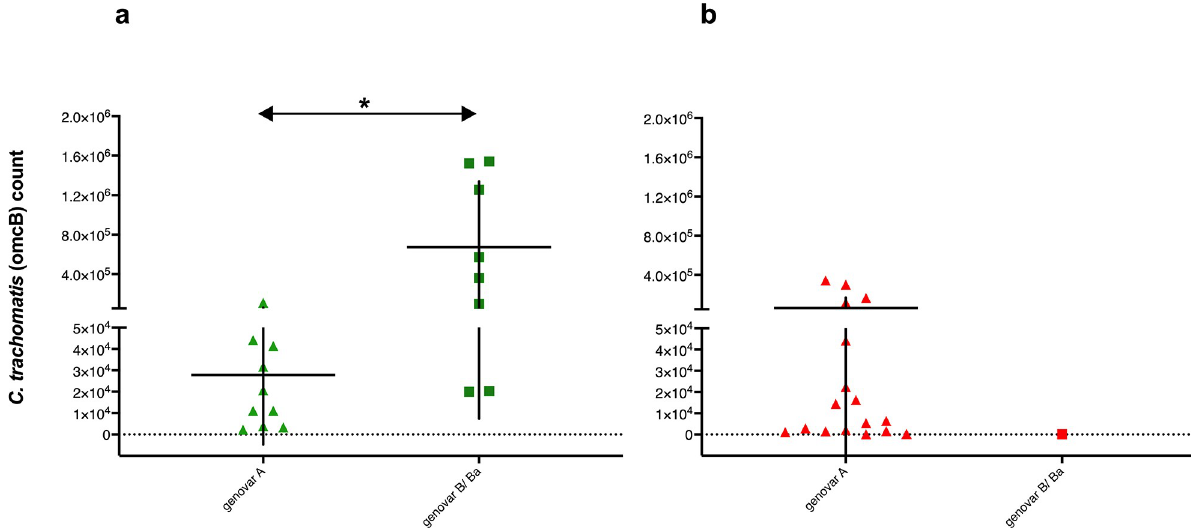
Fig 3. Bacterial loads for different Ct genovars among Moroccan and Sudanese children. Scatter dot-plots show the mean Ct load for genovar A and B/Ba among Moroccan (a) and Sudanese children (b). Moroccan samples are marked in green and samples from Sudan are marked in red. The vertical lines indicate the error bars that express the standard deviations, and the horizontal lines indicate the means. Statistical significance is indicated as follows: � p = 0 �